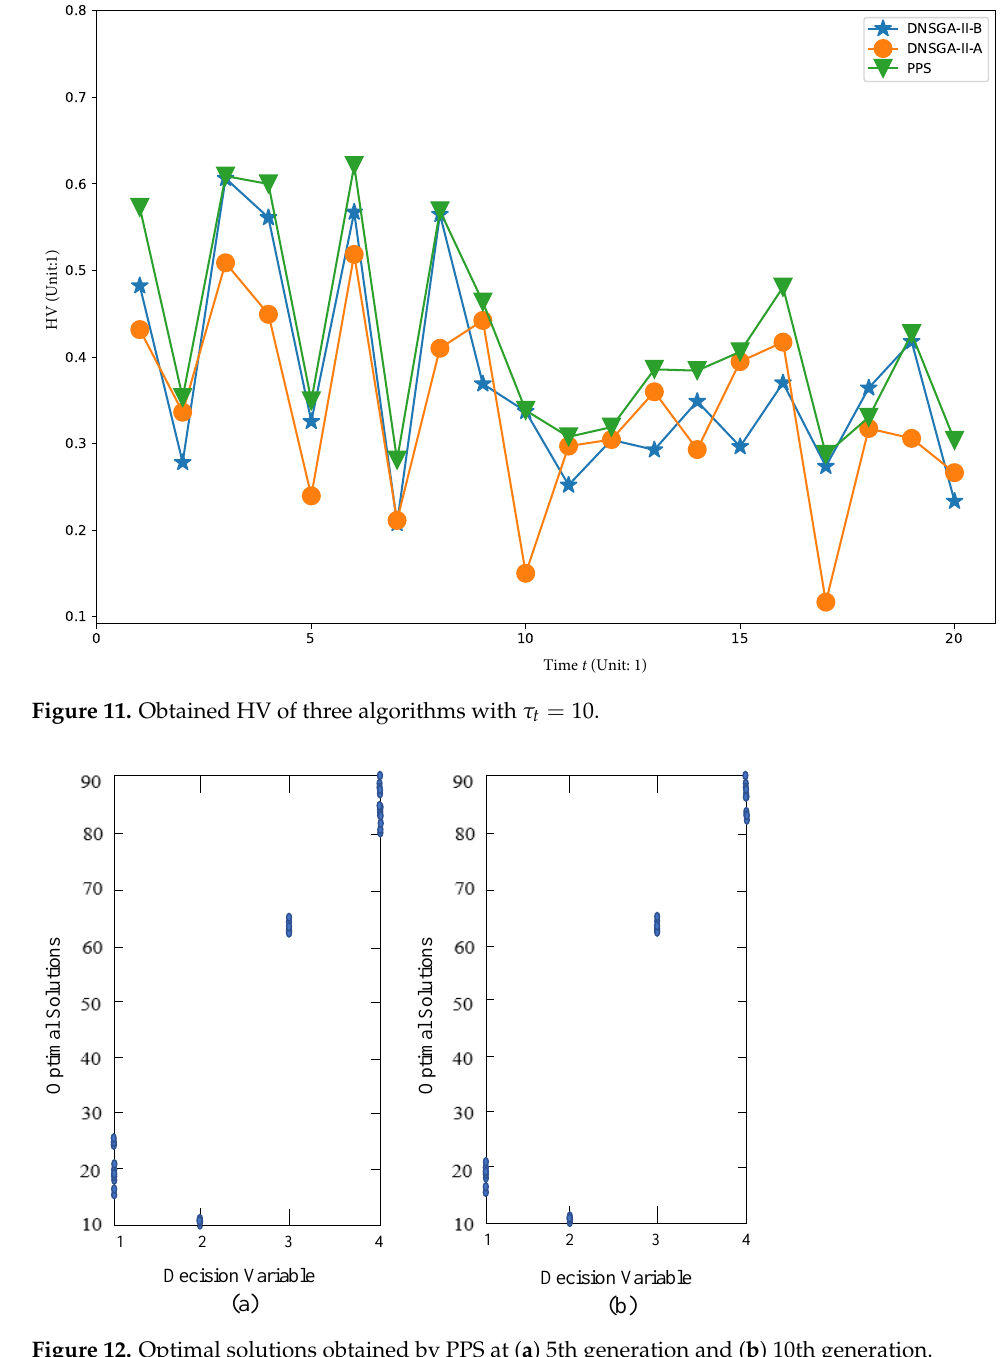
Figure 12. Optimal solutions obtained by PPS at ( a ) 5th generation and ( b ) 10th